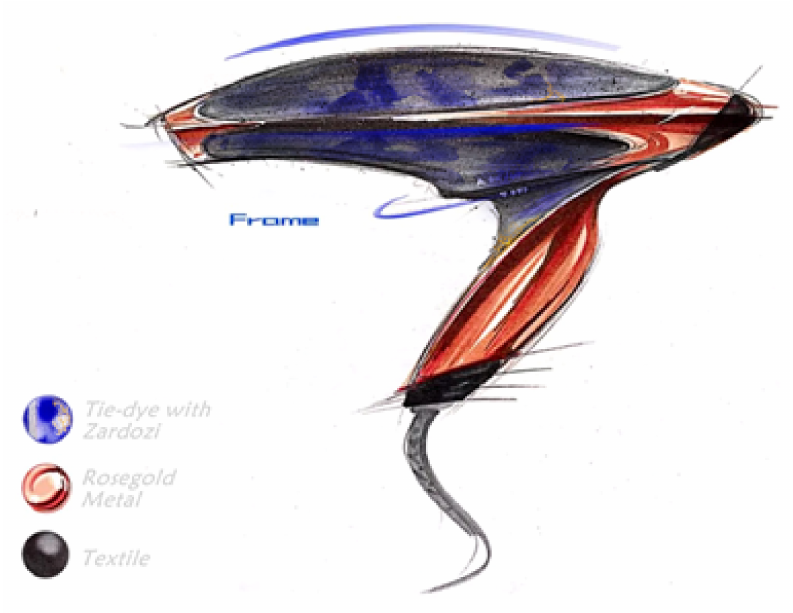
Figure 10. The sketch of the hair dryer inspired by “Tie-dye” and